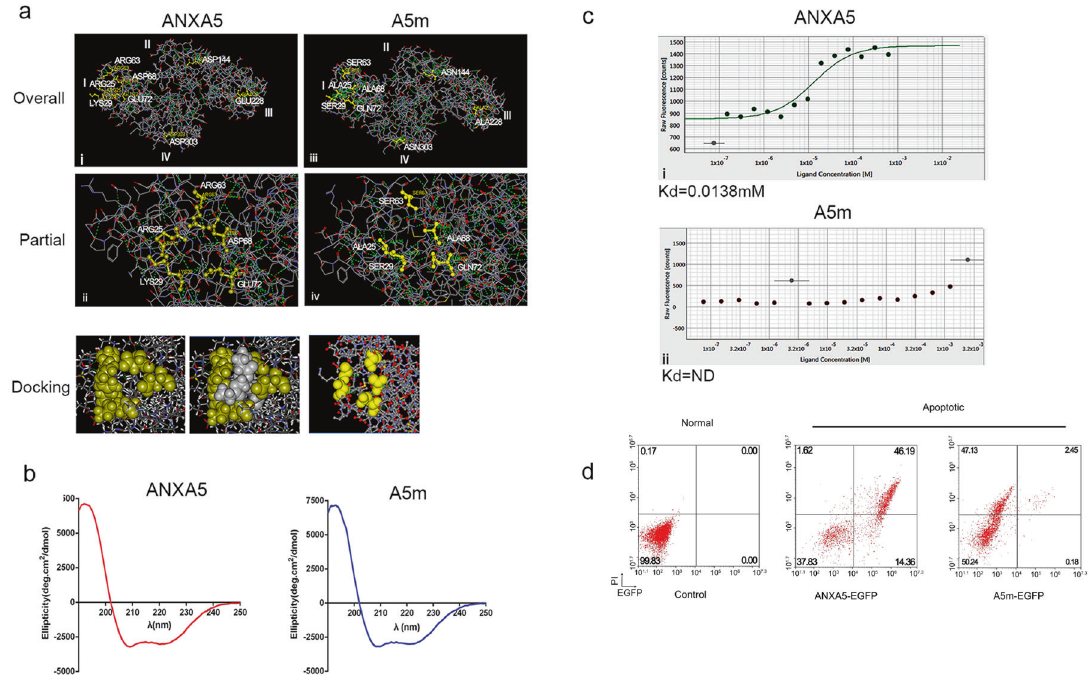
Fig. 2 The mutant A5m is an inactive analogs of ANXA5. a Molecule modeling of ANXA5 and A5m protein. i, iii: overall view of protein conformation; ii, iv: partial view of PS-binding region. The key amino acids responsible for PS-binding in yellow. The PS-binding pocket of ANXA5 is surrounded by R25, K29, R63, D68, and E72 (ii), but mutated in A5m (iv). Using DS docking software (DS2.4), the docked conformation of PS matches the binding pocket of ANXA5, and mismatches with A5m. b The protein conformations of ANXA5 and A5m showed similar structural signals detected by Circular Dichroism (CD) spectrum. c MST analysis of PS liposomes binding on ANXA5-EGFP and A5m-EGFP in the presence of 2.5 mM Ca 2 + . Data are representative of three independent experiments. ND, not determined. d Apoptotic cells were co-stained with PI and ANXA5-EGFP or A5m-EGFP. Normal cells A549 as negative controls. Representative data are from three independent